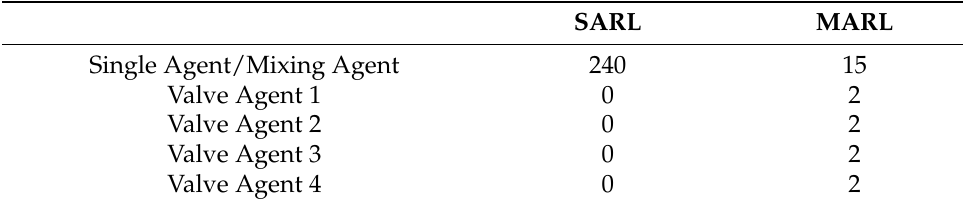
Table 3. Action space for Single Agent RL ann Multi Agent